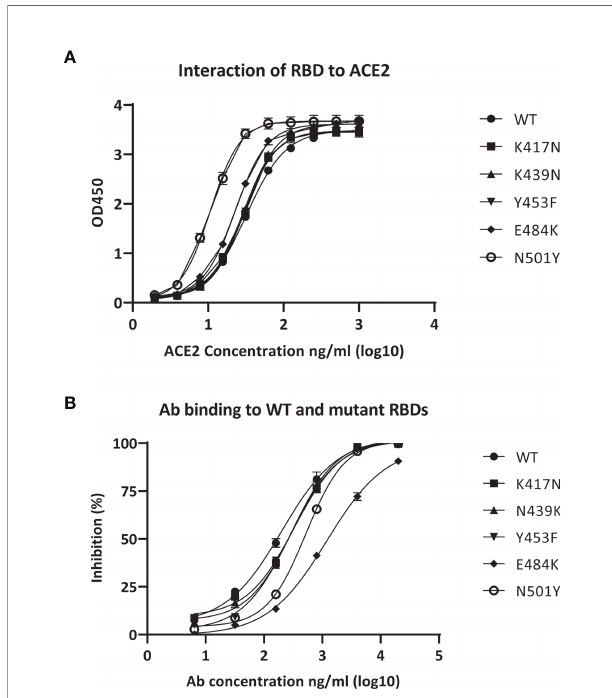
FIGURE 4 | Binding activity of anti-receptor-binding domain (RBD) polyclonal antibodies (pAbs) with various severe acute respiratory syndrome coronavirus 2 (SARS-CoV-2) mutant RBDs. (A) Binding of angiotensin-converting enzyme 2 (ACE2) to immobilized RBDs from wild-type (WT) SARS-CoV-2 and mutants. (B) Binding of anti-RBD pAbs with WT and mutant SARS-CoV-2